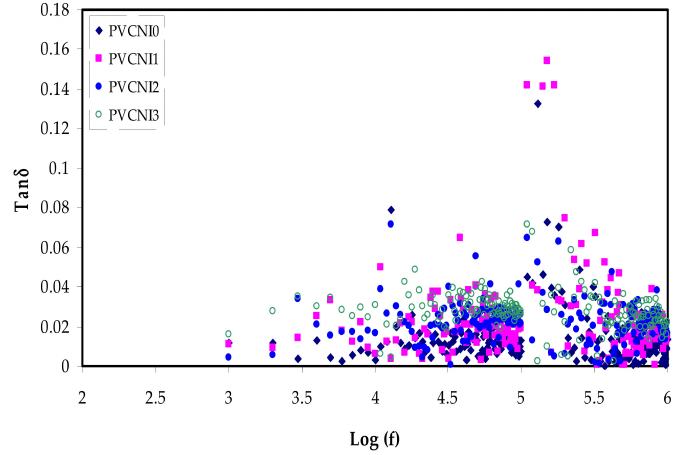
Figure 7. Tan δ versus log ( f ) for all the electrolyte